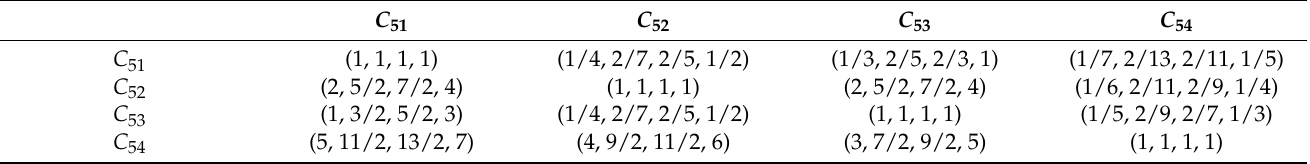
Table A6. Pair-wise comparison matrix of the sub-factor: technics and structure ( C 5 ).